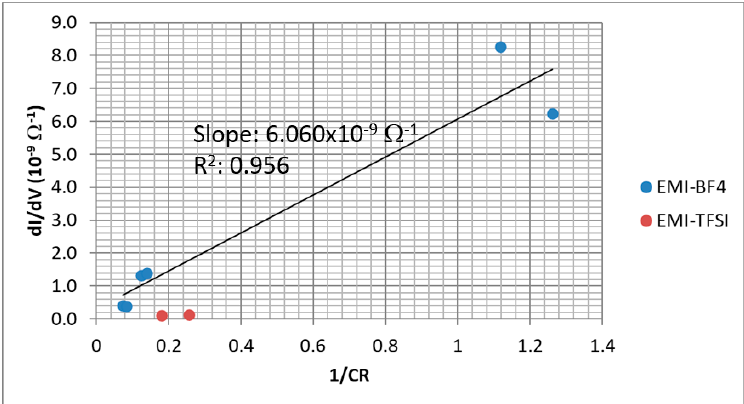
Figure 6. Voltage–current (VI) slopes, B , versus 1 / C R plotted for recent experimental results from the group of Lozano [28,31,32].